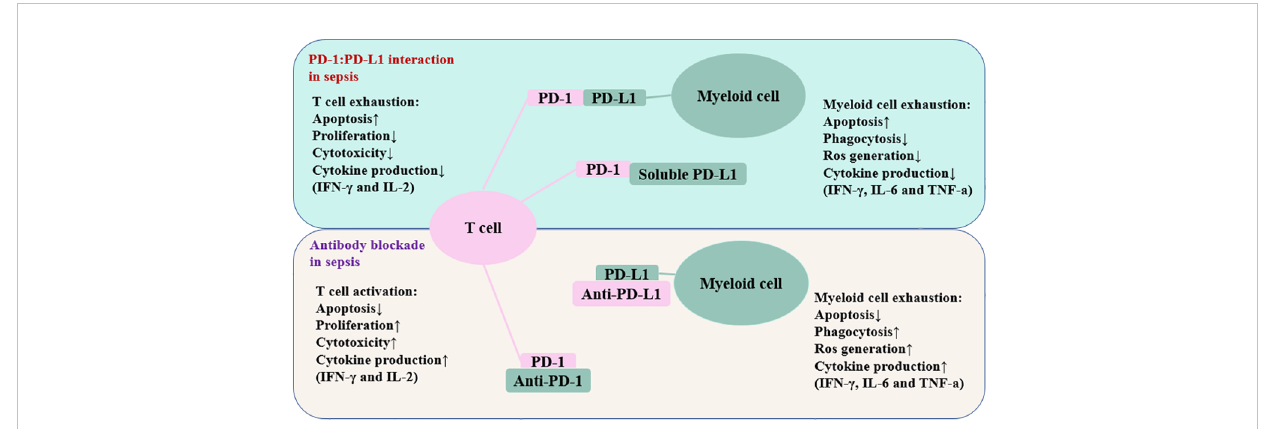
FIGURE 3 Schematic depiction of the PD-1/PD-L1 related immune cell dysfunction. The interaction between PD-1 and PD-L1 impairs T cell function and myeloid cell function. Antibodies against these inhibitory molecules restore the immune system ’ s function and boost resistance to infection in patients suffering from sepsis. The up arrow represents an increase, whereas the down arrow denotes a decrease. PD-1, programmed cell death-1; PD-L1, programmed cell death ligand-1; IFN- g , interferon-gamma; IL-2, interleukin-2; IL-6,